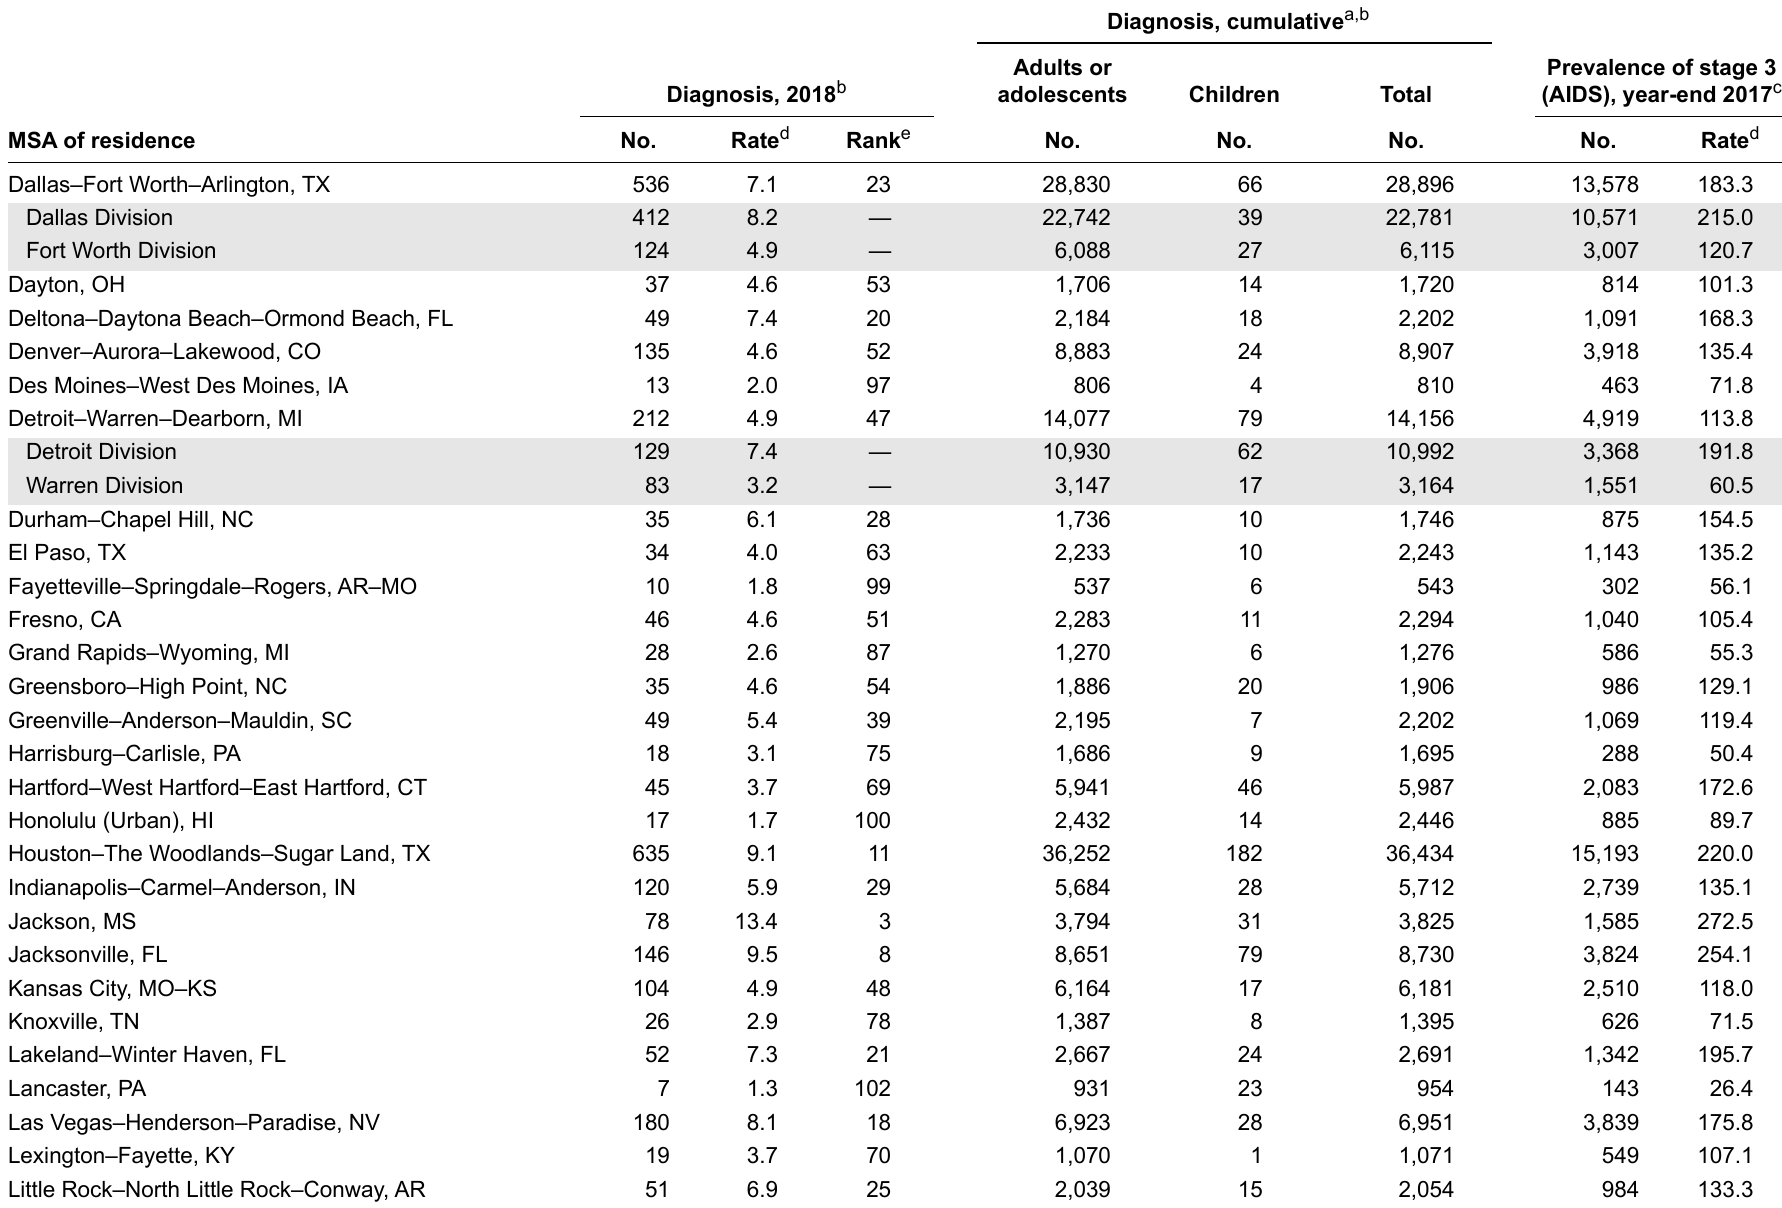
Table 31. Stage 3 (AIDS), 2018 and cumulative, and persons living with diagnosed HIV infection ever classified as stage 3 (AIDS) (prevalence), year-end 2017, by metropolitan statistical area of residence—United States and Puerto Rico